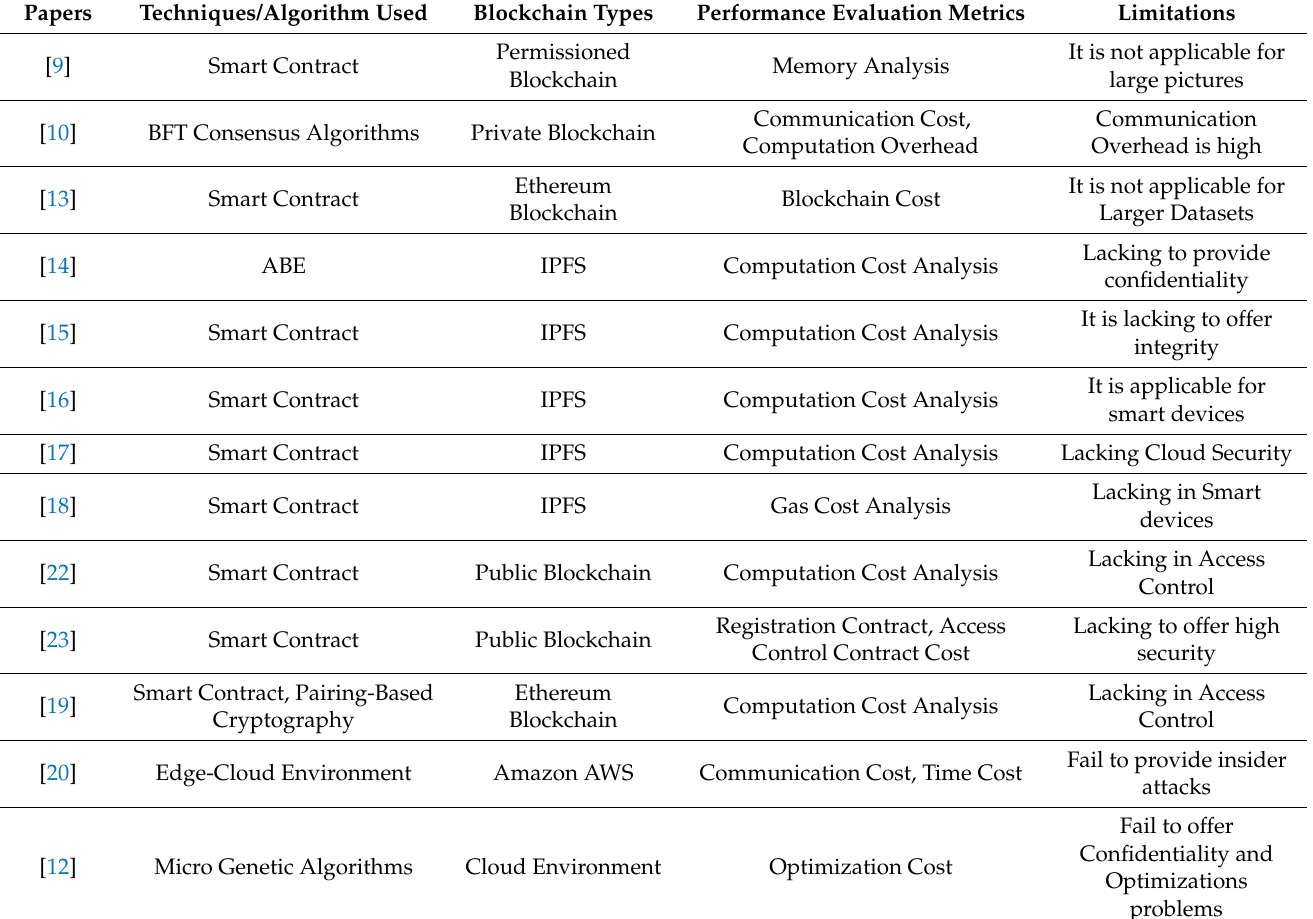
Table 1. The comparison of existing research